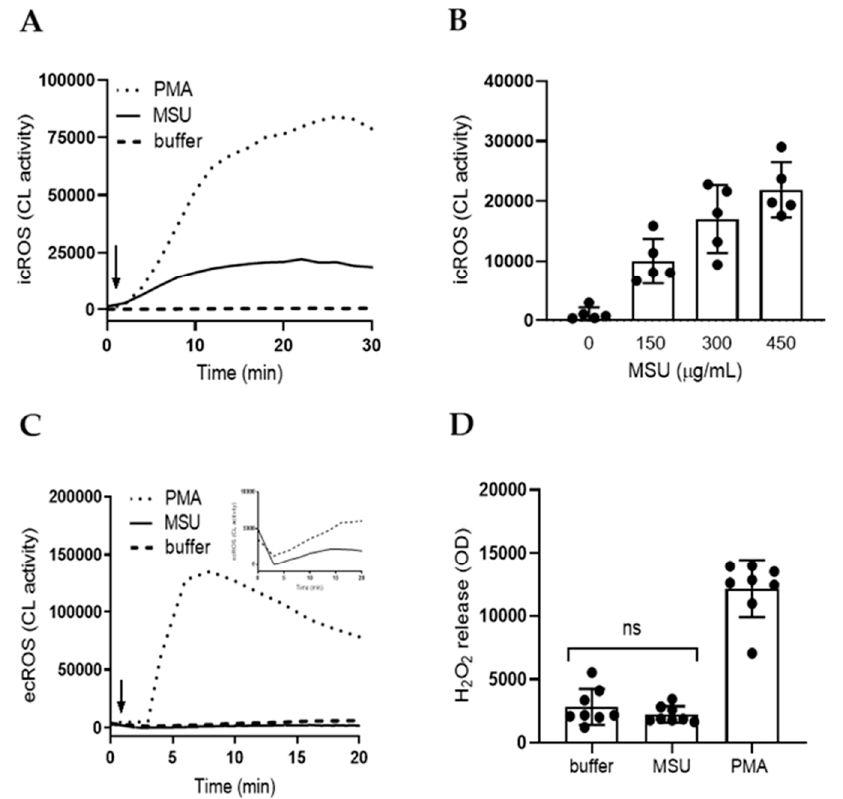
Figure 1. Monosodium urate (MSU) crystals trigger intracellular reactive oxygen species (ROS) production in neutrophils. MSU crystals (300 µg/mL, solid line) triggered significant ( p <0.0001 compared to buffer treated cells, n=16), intracellular ROS (icROS) production in neutrophils, as measured by luminol-amplified chemiluminiscense (CL) ( A ), representative kinetic curves are shown), and a clear dose-dependency could be noted when different concentrations of MSU crystals were used. Shown in ( B ) are mean peak CL values +/ − SD of five independent experiments. ( C ) A representative kinetic extracellular ROS (ecROS) response, as measured by isoluminol-enhanced CL, of neutrophils stimulated with MSU crystals (500 µg/mL, solid line), PMA (50 nM, dotted line) or buffer (broken line). A close-up of the MSU crystal and buffer traces are also shown in the inset. ( D ) MSU crystals (300 µg/mL) did not trigger extracellular H 2 O 2 release above buffer-levels, as measured after 20 min incubation with the H 2 O 2 specific probe Amplex Red. Shown are a mean +/- SD of seven independent experiments. Statistical significance was calculated by the use of the Wilcoxon matched- pairs signed rank test.